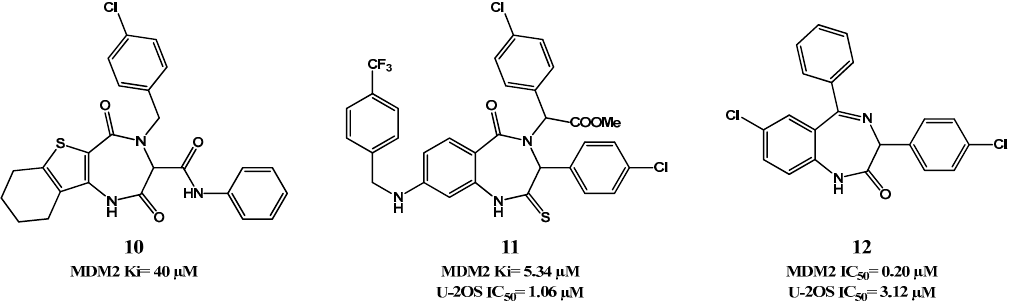
Figure 4. Examples of benzodiazepinedione derivatizations.